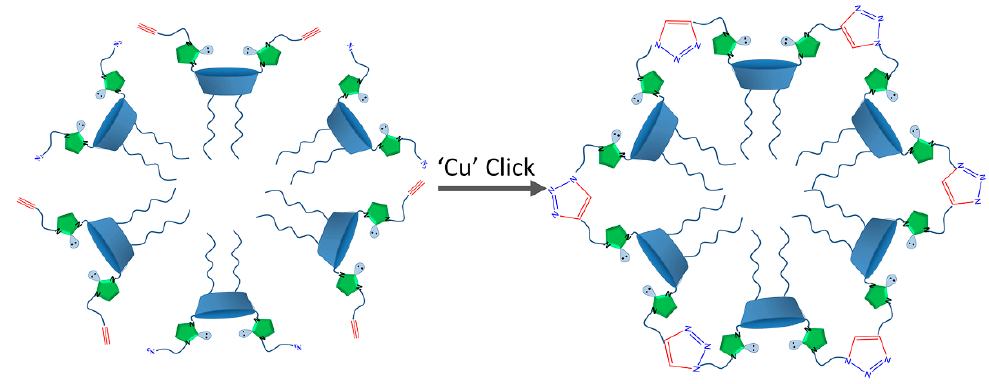
Scheme 1. Representation of the formation of polymeric nanoparticles using a supramolecular